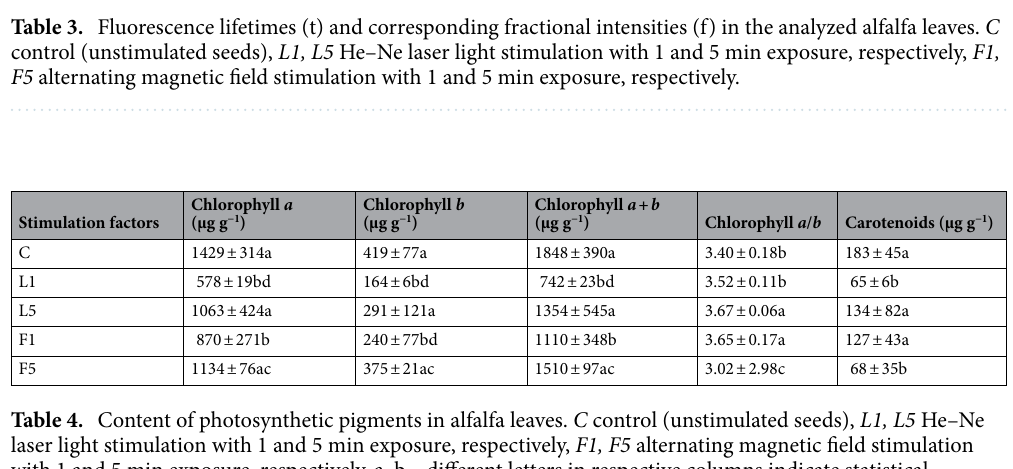
Table 4. Content of photosynthetic pigments in alfalfa leaves. C control (unstimulated seeds), L1, L5 He–Ne laser light stimulation with 1 and 5 min exposure, respectively, F1, F5 alternating magnetic field stimulation with 1 and 5 min exposure, respectively. a, b—different letters in respective columns indicate statistical differences, ± standard deviation, n = 3.